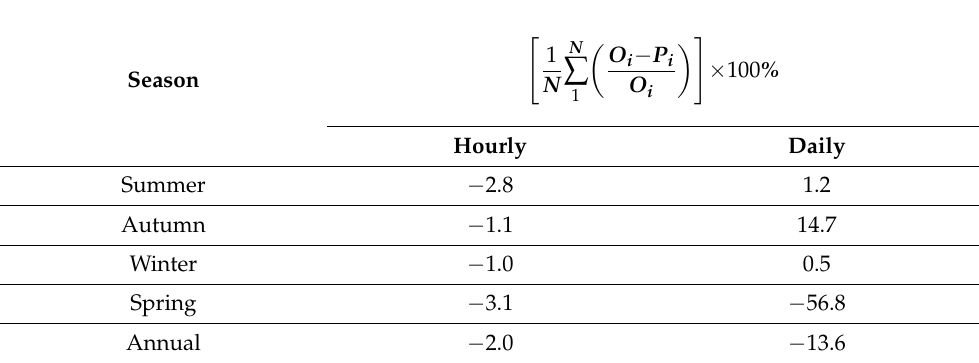
Table 6. Season average of the relative difference between observed ( O i ) and modelled ( Pi ) values.